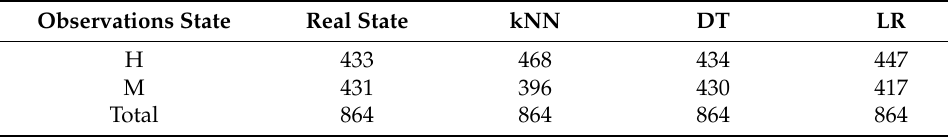
Table 6. Prediction results for application case 1.